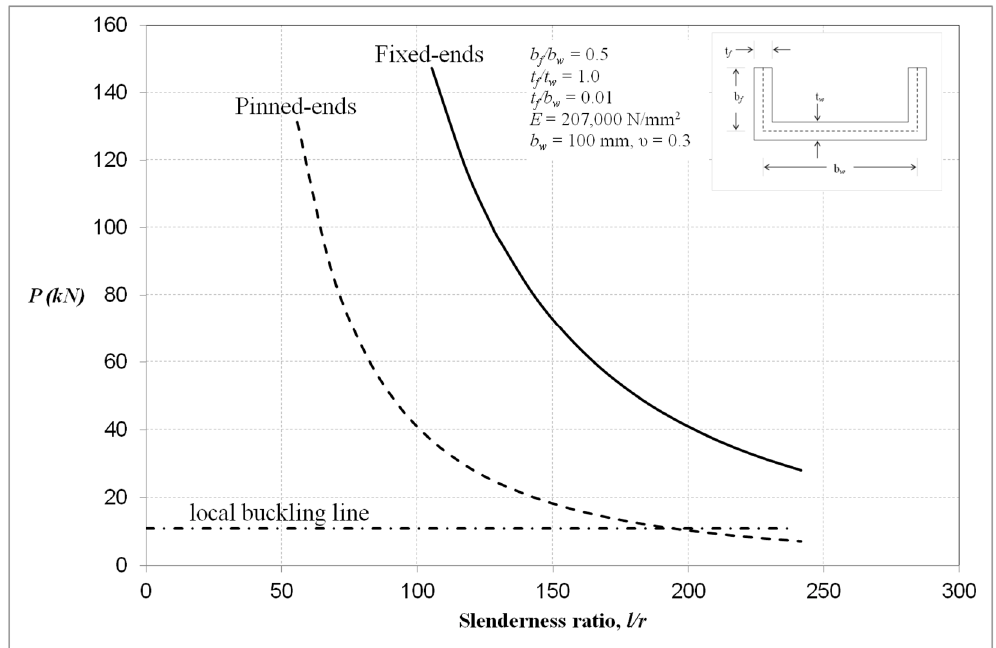
Figure 3. Euler curves for singly-symmetric plain channel column.